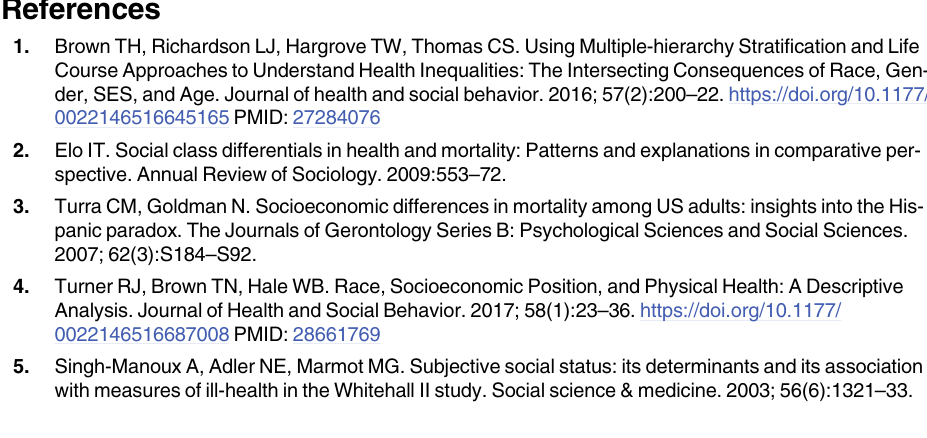
S1 Table. Descriptives of the ELSA and Whitehall II-sample. S2 Table. Material class and subjective social status regressed on the separate health bio- markers with control variables. S3 Table. Material class and subjective social status regressed on Unhealthy Behaviors including control